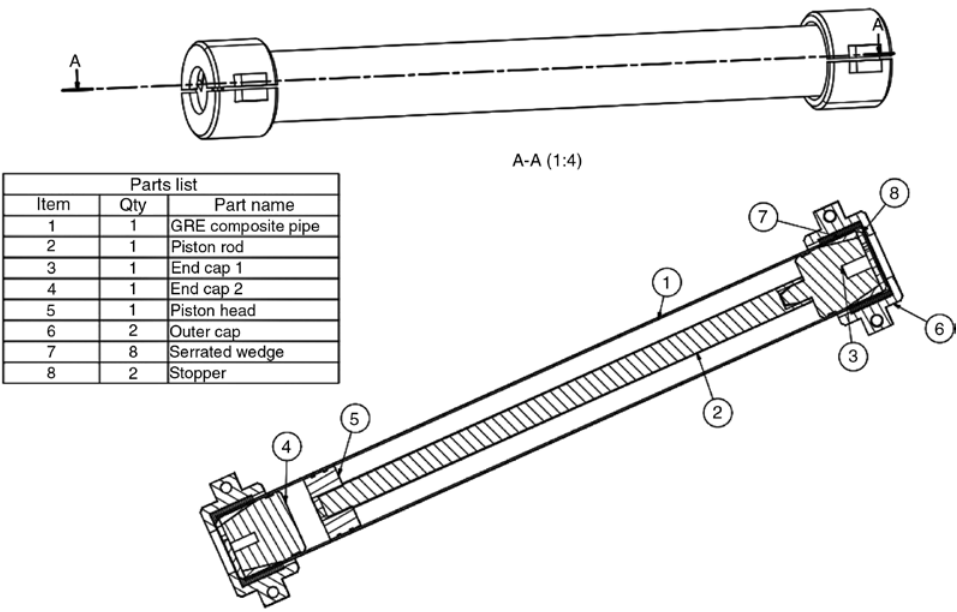
Figure 7: Cross-sectional view of pipe with end caps and piston.